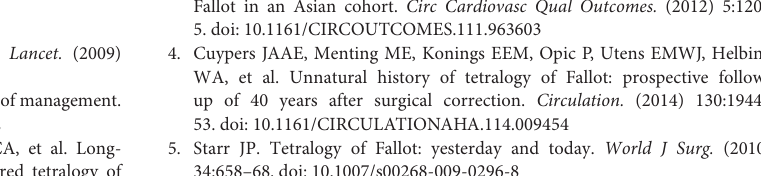
FIGURE 4 | ( r = − 0.534, P < 0.001). (C) The PV z -score had positive correlation with LV GLS ( r = 0.515, P < 0.001). (D) The PV z -score had a positive correlation with RV GLS ( r = 0.417, P = 0.002). (E) The MPA z -score had positive correlation with LV GLS ( r = 0.442, P = 0.001). (F) The MPA z -score also had positive correlation with RV GLS ( r = 0.344, P = 0.013). All the GLS values were presented as absolute values. GLS, global longitudinal strain; AV, aortic valve; PV, pulmonary valve; MPA, main pulmonary